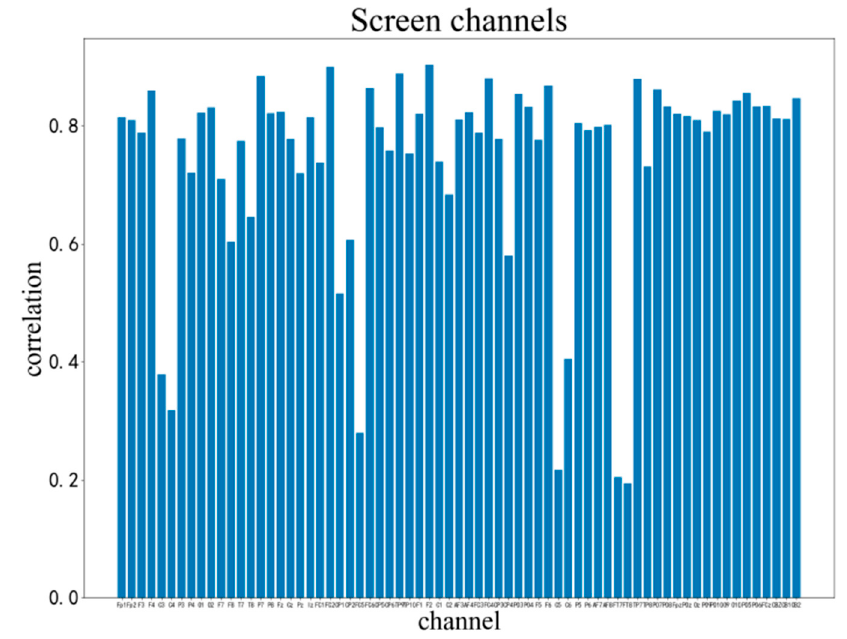
Figure 11. Correlation index of correct and error execution of each electrode of the subject 03.